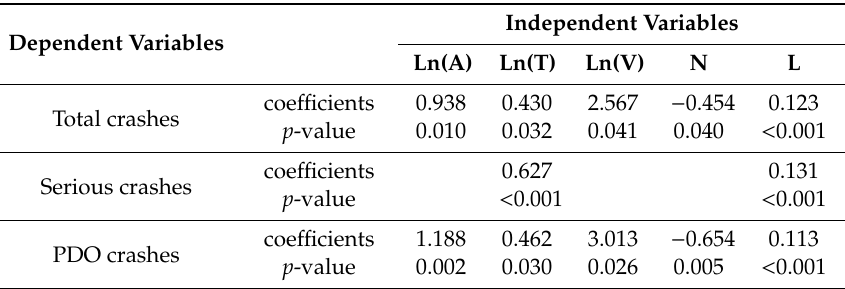
Table 3. Safety performance function.